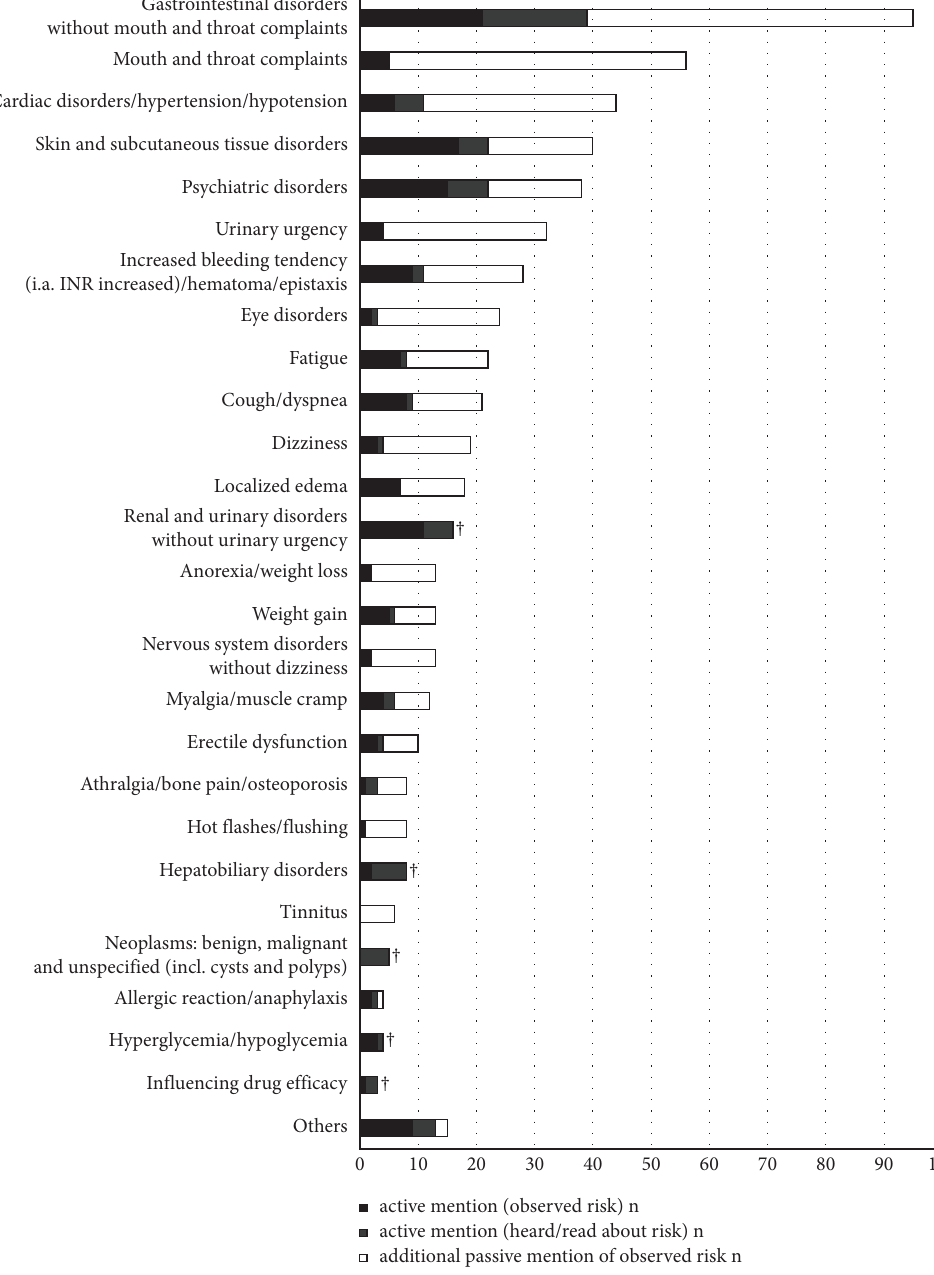
Figure 4: Patients’ association of risks with their therapy. Patients mentioned risks actively without any suggestion or passively based on a list of suggestions. Every single mentioned risk was counted and categorized. Multiple risks per patient were therefore possible. Diferent risks could be categorized into the same AE category per patient. † AE category was not on the predefned list; therefore, passive mention was not